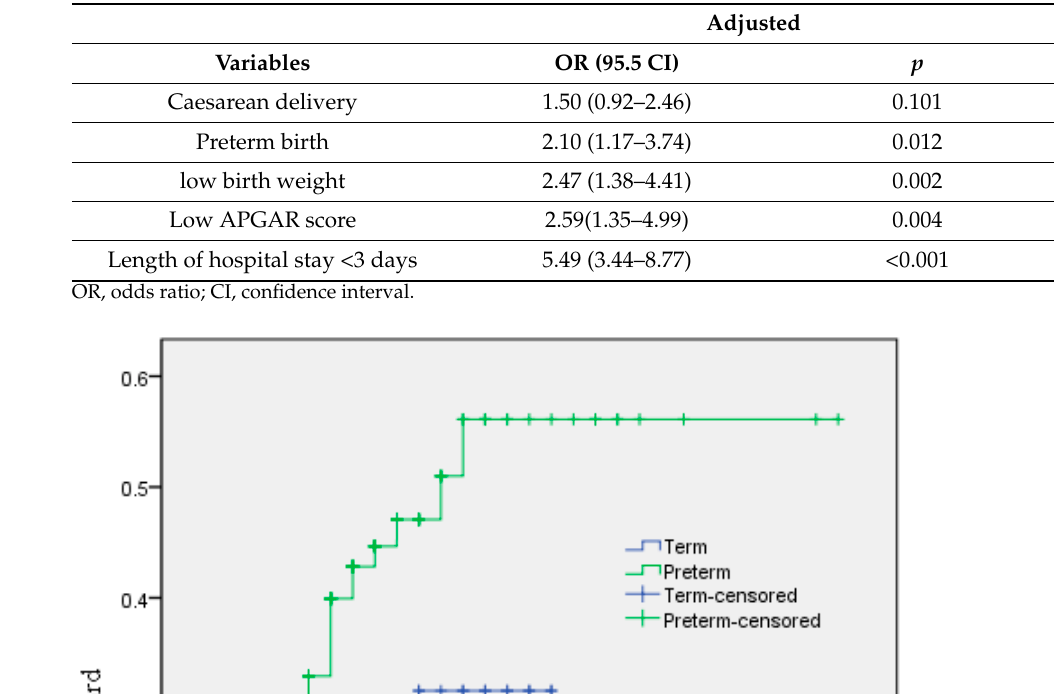
Table 3. Logistic regression of factors associated with neonatal mortality in the neonatal intensive care unit of Gadarif hospital.